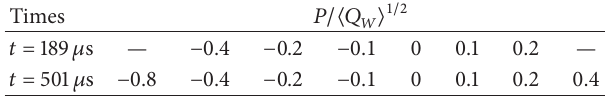
Table 2: Selected dimensionless 𝑃